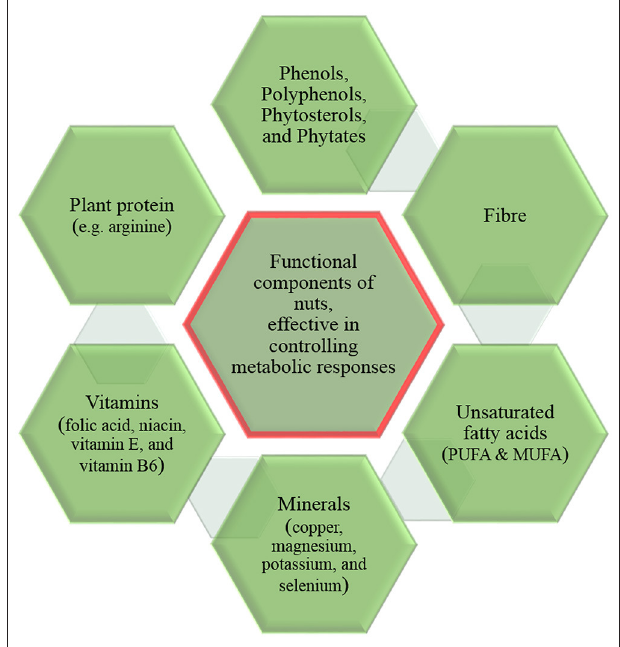
FIGURE 1 | Beneficial components of nuts offering health